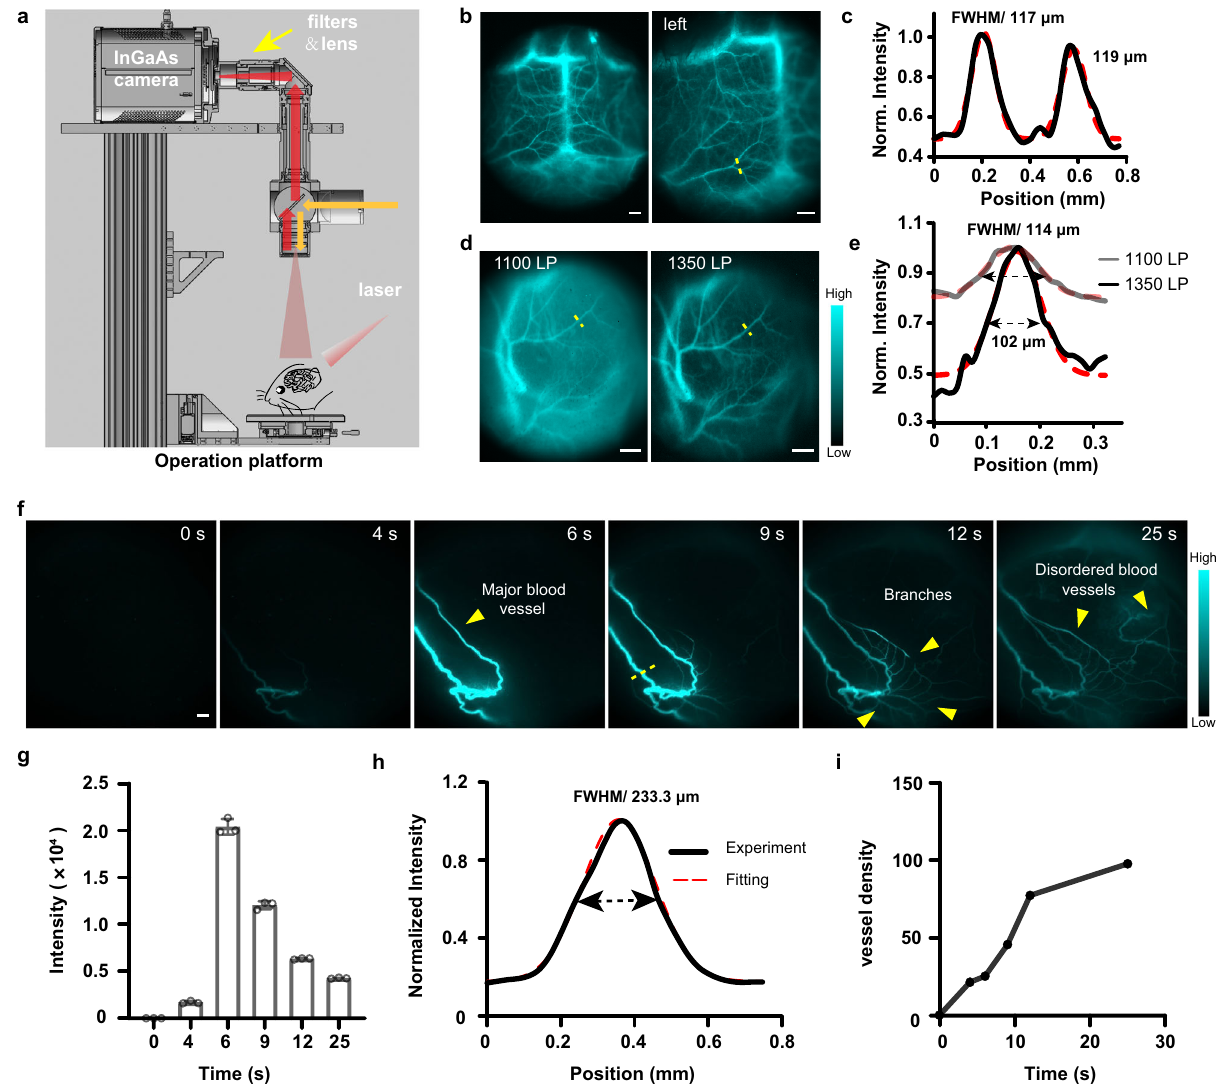
Fig. 5 In vivo NIR-II imaging for the vascular network of brain and tumor. a Scheme of zoom-stereo microscope NIR-II imaging system. b Representative NIR-II fl uorescent images of cerebral vessels post intravenous injection of FT-TQT@FBS complexes. Scale bar: 1 mm. c Cross-sectional fl uorescence intensity pro fi le along the yellow line shown in panel ( b ). A Gaussian function fi tted to the data (with FWHM) is also shown in red. d The tumor vessels of a mouse using FT-TQT@FBS complexes contrast at 1100 nm and 1350 nm LP fi lters. Scale bar: 1 mm. e Cross-sectional fl uorescence intensity pro fi les (and Gaussian fi ts (red) with FWHM indicated by arrows) along the yellow lines in panel ( d ). f The recorded NIR-II video of tumor vasculatures in nude mice with xenograft osteosarcoma 143B at several time points p.i. of the FT-TQT@FBS complexes at 1100 nm LP fi lters. Scale bar: 1 mm. g The monitor of the fl uorescence intensity pro fi le of tumor vessels in NIR-II video imaging of f . Data are presented as mean ± s.d. derived from n = 3 independent measurements. h Cross-sectional intensity (solid black line) and Gaussian fi t fl uorescence intensity pro fi les (dotted red line) along the yellow lines in panel ( f ). i Quantitative analysis of the vascular density of tumor by using a vascular segmentation and quanti fi cation algorithm in panel ( f ). Norm, Normalized. The detailed imaging parameters for each image are listed in Supplementary Table fl uorescence brightness of FT-TQT@FBS was 5-fold, 6.6-fold and 26 = 0.05%), CH-PEG (QY = 0.03%; IR-26 = 0.05%) and IR-26